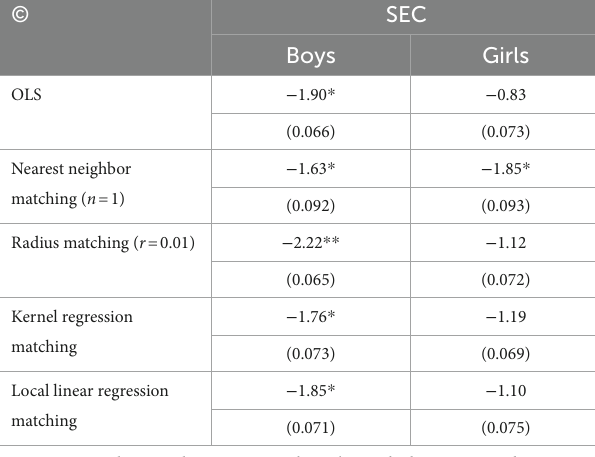
TABLE 5 Heterogeneity analysis of the SEC development of left-behind children of different genders